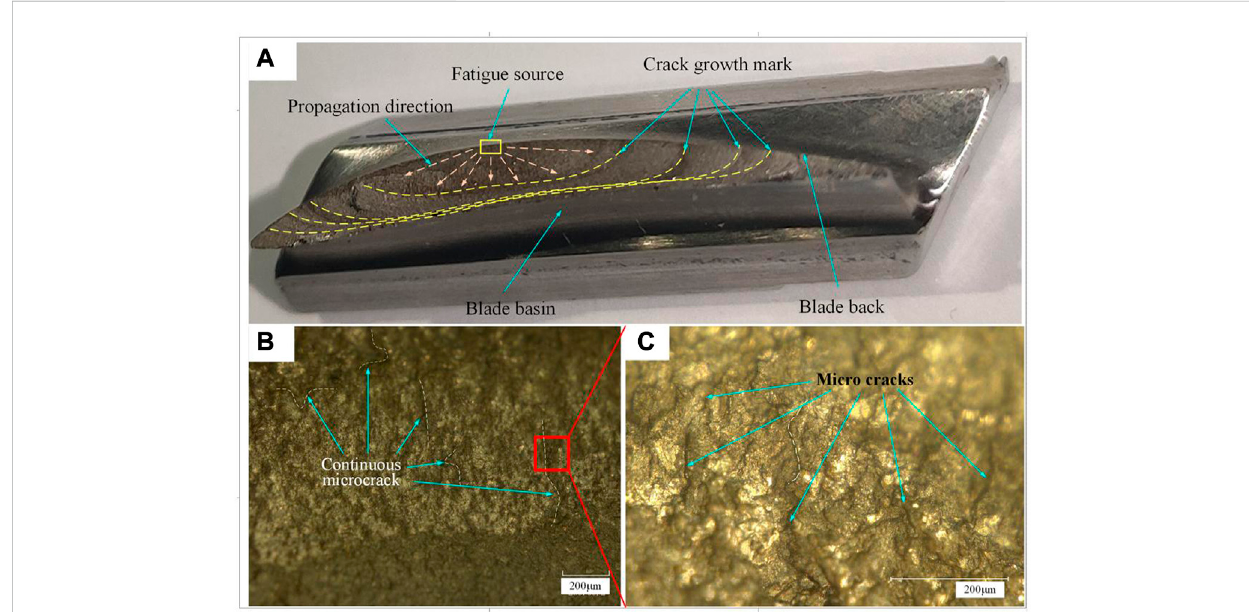
FIGURE 6 Section morphology of the fatigue fracture blade. (A) Overall characteristics of the section, (B) partial morphology of the section, and (C) micro- cracks on the